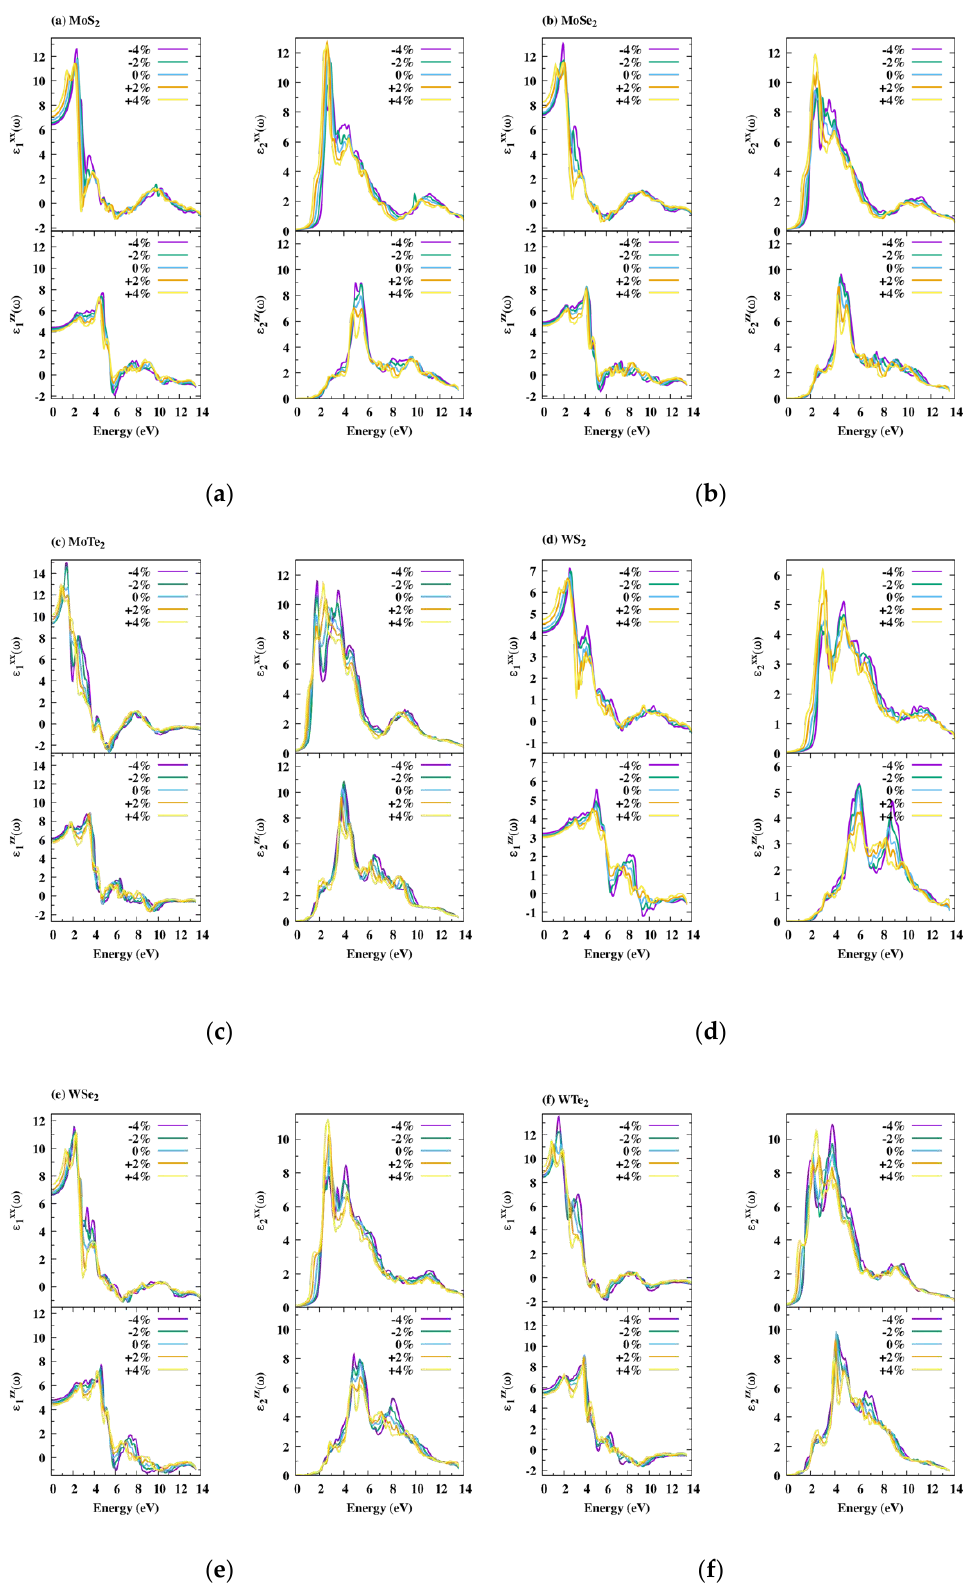
Figure 6. Real ε 1 (ω) and imaginary ε 2 (ω) parts of the relative permittivity function with respect to photon energy under biaxial, −4% and −2% compressive strains and +2% and +4% tensile ones. ( a ) MoS 2 ; ( b ) MoSe 2 ; ( c ) MoTe 2 ; ( d ) WTe 2 ; ( e ) WSe 2 ; ( f ) WTe 2 .